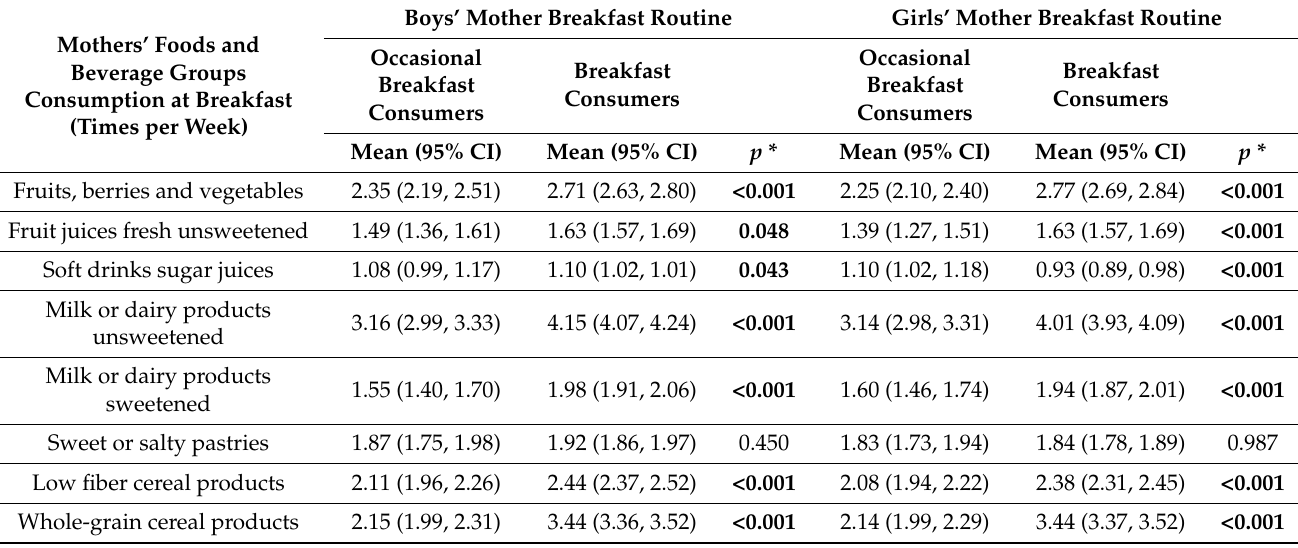
Table 6. Analysis of covariance between food and beverage consumption at breakfast and breakfast routine in mothers, stratified by